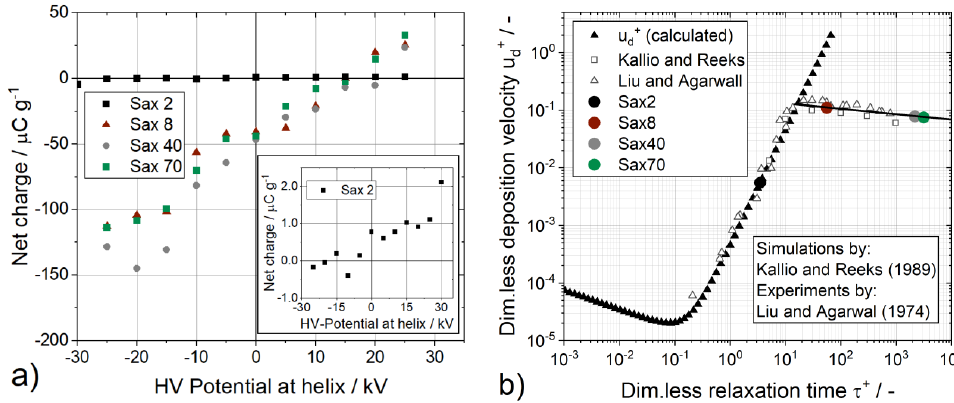
Figure 5. ( a ) Specific net charge per mass for different sizes of Saxolith (limestone) and varied po- tential at the copper helix; insert: zoom for Saxolith 2 particles. ( b ) Dimensionless deposition velocity vs. dimensionless relaxation time for turbulent deposition, calculated for Saxolith 2, 8, 40, and 70 particles and compared to the literature data [44,45] (calculation in Appendix B). The slope of the mass-specific net charge vs. applied potential is found to be nearly constant throughout the particle sizes of Sax 8, Sax 40, and Sax 70, while Sax 2 shows a different behavior, as discussed below. The particle wall collision is assumed as a single Hertzian contact of a spherical particle to understand the constant slope. Then, the charge transferred between an isolating particle and a conducting wall (charge relaxation time τ el >> contact duration ∆ t ) in a single collision can be calculated in the following way [46 – 48]: ∆𝑞 𝑠𝑖𝑛𝑔𝑙𝑒 = 𝜀 0 𝜀 𝑟 𝑆 𝑧 0 ∆𝑉 ∆𝑡 𝜏 𝑒𝑙 (3) 𝑤𝑖𝑡ℎ: ∆𝑡~𝑑 𝑝 𝑢 𝑝 𝛼 ; 𝑆~𝑑 𝑝2 𝛼 ; 𝜏 𝑒𝑙 = 𝜀 0 𝜀 𝑟,𝑝 ∙ 𝛽 𝑝 ; 𝛼~[𝜌 𝑝 (1 − 𝜈 𝑝2 𝐸 𝑝 + 1 − 𝜈 𝑤2 𝐸 𝑤 )] 4 5 where ν p , ν w , E p , and E w are the Poisson ratio and the Young modulus of the particle or wall, respectively. Furthermore, z 0 is the critical gap between the particle and the wall, u p is the particle velocity, and S the surface of the particle in contact with the wall. The elec- trical relaxation time is τ el , and the electrical resistivity of the particle material is β p . However, the number of collisions must be known to compare the totally transferred charge along the helix (Equation (1)) with the transferred charge in a single collision (Equation (3)). As an approximation, the concept of turbulent deposition in a fully devel- oped turbulent pipe flow can be employed. Here, the deposition rate (also called deposi- tion velocity) is calculated from the particle flux towards the wall and the particle number concentration outside of the viscous sublayer [49]. According to Liu and Agarwal [44], the deposition velocity as a function of the dimensionless aerodynamic relaxation time (τ ae+ ) increases first in a quadratic manner (calculated by Equations (A1) – (A3) — Appendix B) and later reaches a plateau (cf. Figure 5b). The dimensionless relaxation time is the ratio of the particle stop distance to the characteristic turbulence length. Regarding the turbu- lent flow in the helix, the flow field can be assumed to be fully developed but becomes more complicated compared to a straight tube, since, additionally, Dean vortices occur. Due to the comparable curvature of the pipe, Reynolds numbers, and Stokes numbers, the work of Noorani et al. [50] can explain the occurrence of Dean vortices in the applied setup of this work. The simulations revealed that the higher the Stokes number or the tube cur- vature, the more the particles followed the Dean vortices within the pipe on a macroscopic level but experienced inertial effects on a microscopic level, leading to wall collisions.